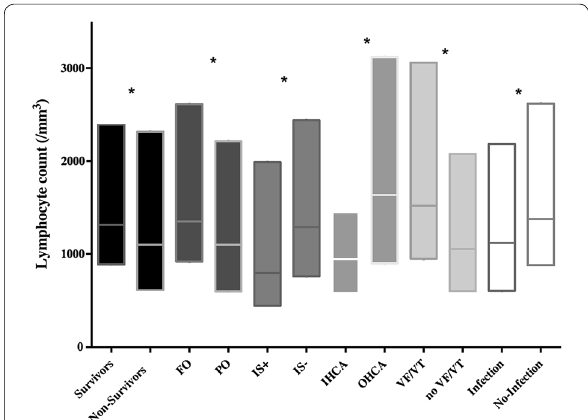
Fig. 1 Differences in lymphocyte counts on admission among survivors versus non‑survivors; patients with favourable (FO) versus unfavourable neurological outcome (UO); patients receiving immu‑ nosuppressive agents (IS ) versus others (IS ); patients with in‑ + − hospital (IHCA) versus out‑of‑hospital cardiac arrest (OHCA); patients with shockable rhythms (VF/VT) versus others (no VF/VT); patients who developed infection versus those without infection. Data are presented as median and 25th ( lower limit ) and 75th percentiles ( upper limit ). * p < 0.05 for lymphocyte count